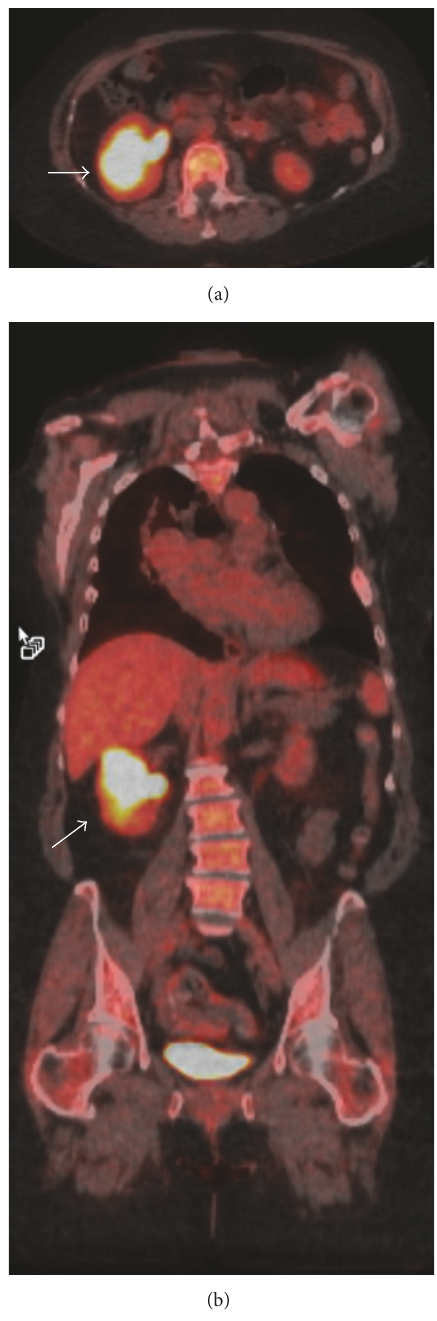
Figure 2: Positron emission tomography shows an intensely fluorodeoxyglucose-avid right renal mass with imaging character- istics highly suspicious for renal cell carcinoma (white